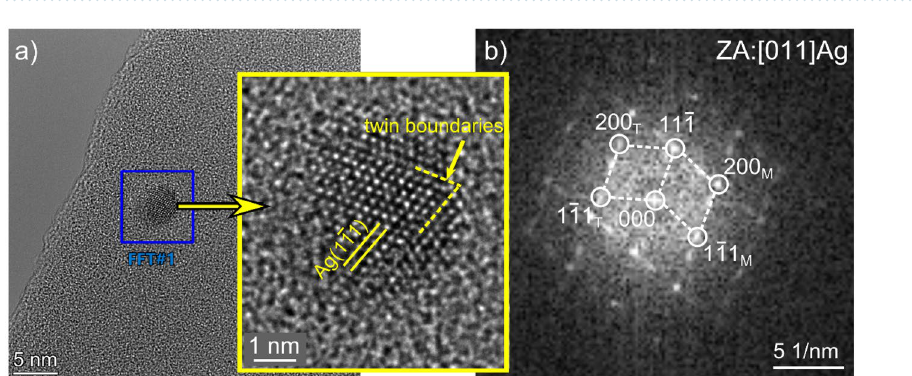
Figure 3. HREM image of single Ag nanoparticle oriented along [011] direction magnified in inset ( a ) and accompanying FFT ( b ) with reflexes from the matrix (M) and twins